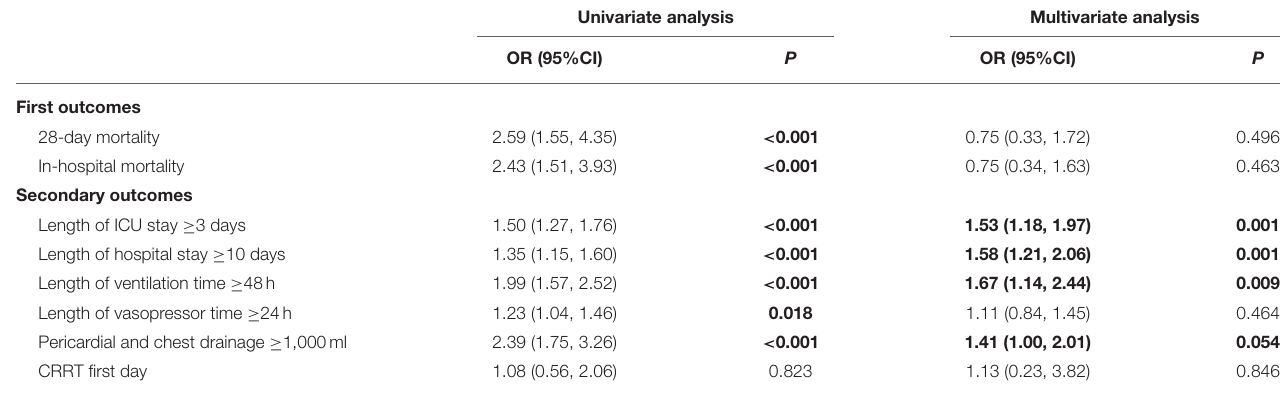
TABLE 4 | The associations between postoperative thrombocytopenia and clinical